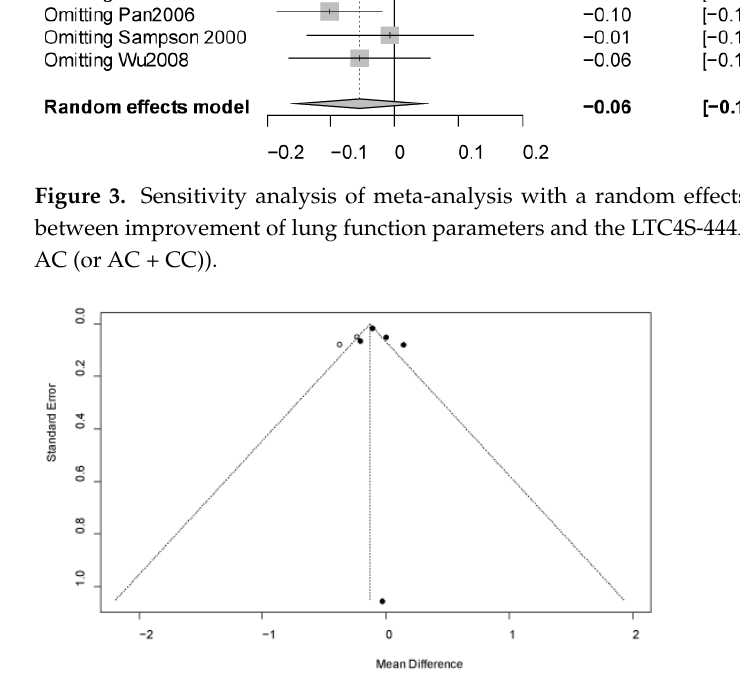
Figure 4. Begg’s funnel plot for publication bias of studies included in LT4CS-444A/C gene meta- analysis. The black dot represents the original study, the vertical line in the middle represents the MD value of the combined effect, and the diagonal areas on either side of the vertical line represent the 95% confidence intervals for the combined effect at different standard error scales. The white dot represents the new study that need to be added to correct the asymmetry of the funnel plot.